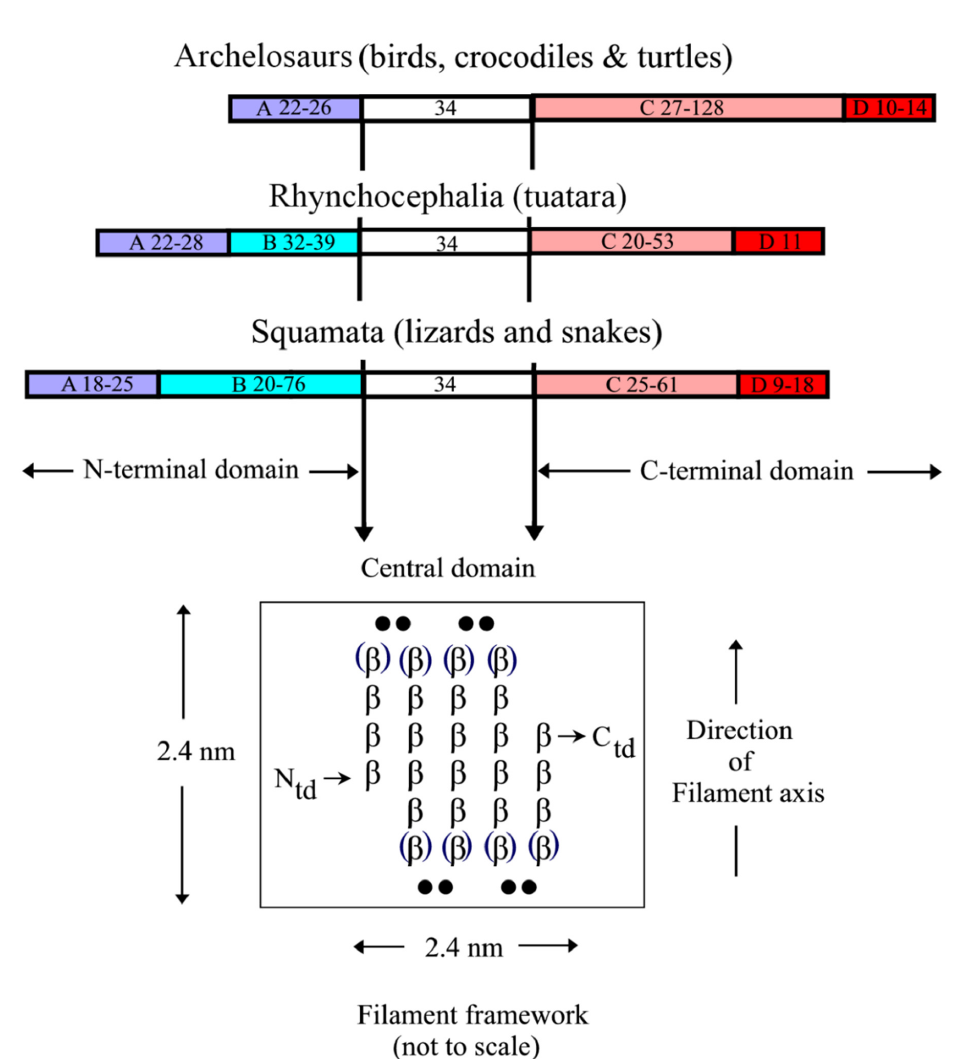
Figure 4. Sequence comparisons of the CBPs from the sauropsids reveal that the N-terminal domain is comprised of subdomain A in the archelosaurs, but subdomains A and B in the squamates and rhynchocephalia. The C-terminal domain, however, comprises subdomains C and D in all of the sauropsids. The sequence characteristics of each subdomain are listed in the text. The approximate size ranges of the subdomains are listed. The central 34-residue domain adopts a twisted ß-sheet structure with three inner strands and two partial outer ones that assembles in an antiparallel manner with a similar sheet from a different chain to form a ß-sandwich. In turn, these assemble axially with a four-fold screw symmetry to form a filamentous structure of diameter 3.4 nm. Figure reproduced from [58] with permission of Springer. A number of other, key observations provided support for these conclusions. Firstly, one face of the ß-sheet in the 34-residue repeat was shown to be largely composed of apo- lar residues (amphipathic), thereby providing a ready and simple means by which a pair of these sheets could assemble via their apolar faces to form a ß-sandwich [30]. The am-